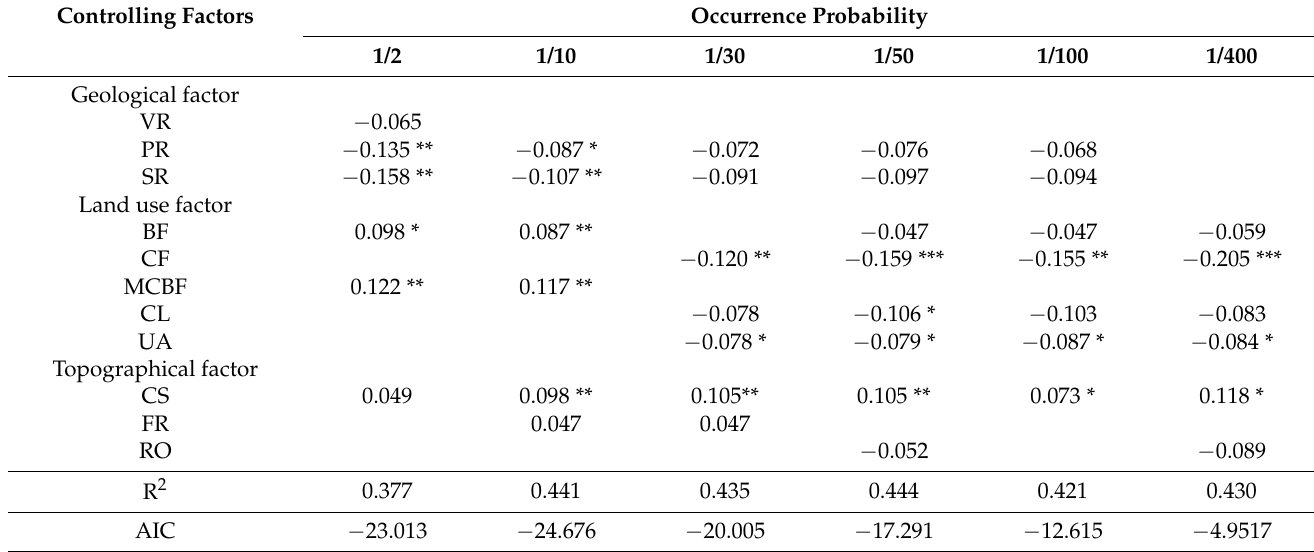
Table 3. Analysis of the relationship between drought runoff coefficient of each occurrence probability and controlling factors by GLM Controlling Factors Occurrence Probability Geological